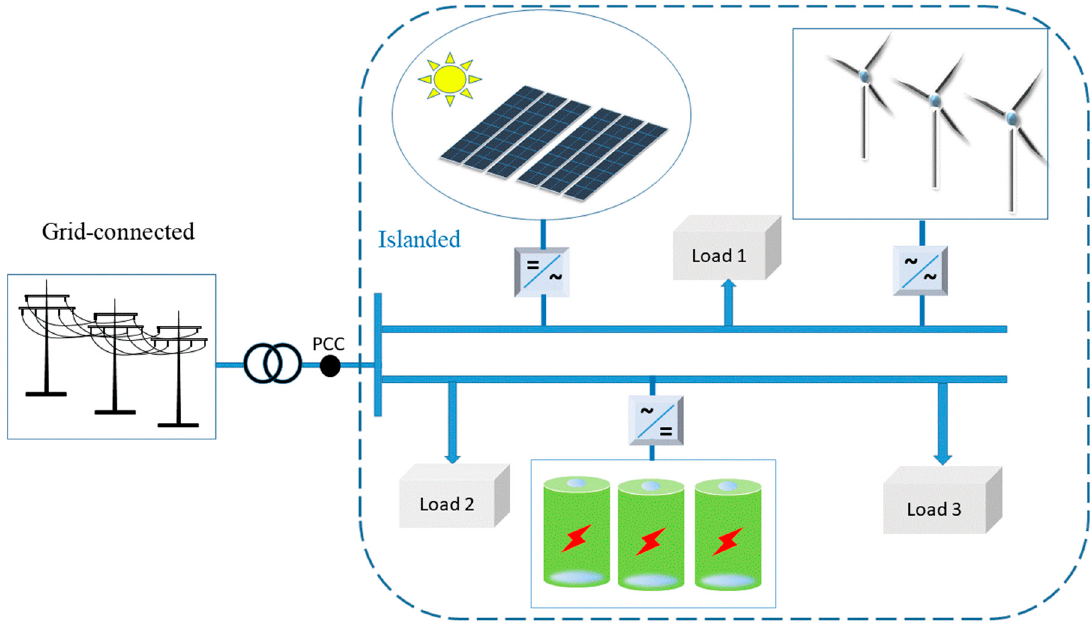
Figure 1. Typical structure of an alternating current (AC) microgrid (MGs) system.